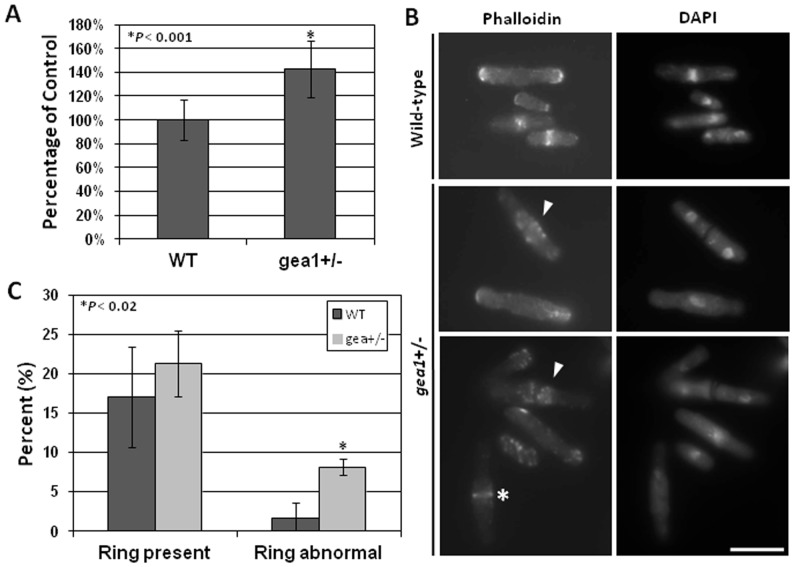

Gea1+/− cells exhibit defects in cytokinesis.A. Cell length of wild-type (n = 221) and gea1+/− cells (n = 205) was measured based on phase-contrast images. Error bars represent mean ± SEM from 3 independent experiments. *p<0.001. B. Wild-type and gea1+/− cells were stained with DAPI to visualize nuclei and Alexa 568-phalloidin to visualize F-actin. Staining in gea1+/− cells revealed the presence of numerous septated cells exhibiting disorganized contractile acto-myosin rings. Asterisk indicates a normal contractile ring, and arrowheads indicate abnormal rings in gea1+/− cells. Scale bar, 10 µM. C. Quantification of the percentage of cells containing an actomyosin ring or an abnormal ring in wild-type (n = 176) and gea1+/− cells (n = 180). Error bars represent mean ± SD from 3 independent experiments. *p<0.02.